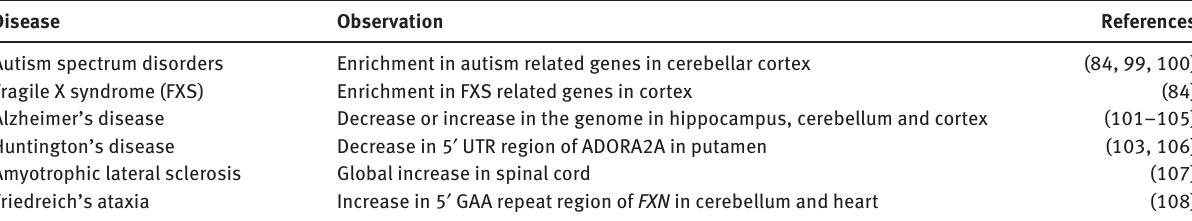
Table 2: Human diseases and observed aberrant 5-hydroxymethylcytosine levels. a